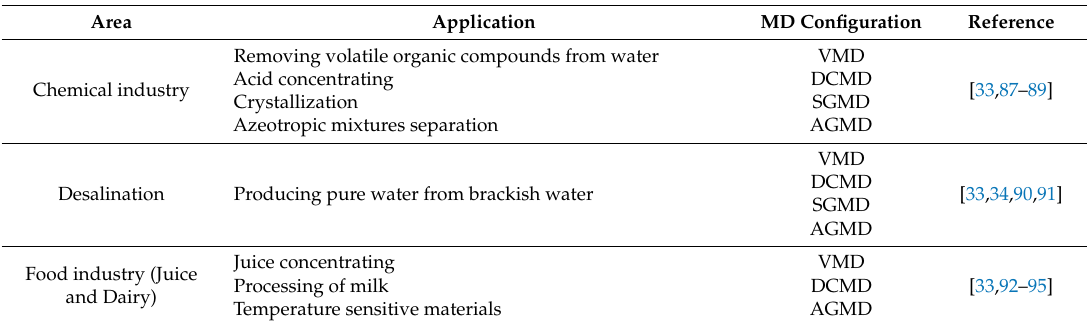
Table 5. The application of the MD process in different industries.